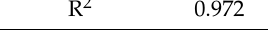
Table 5. Goodness-of-fit statistic. Log